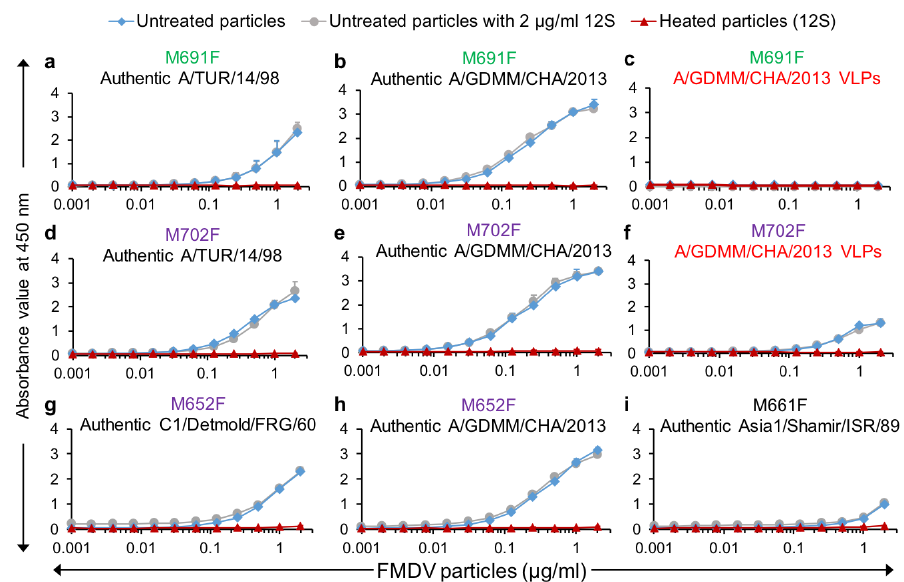
Figure 5. Capsid specificity of selected VHHs and interference of 12S particles in capsid quantification in DAS-ELISAs. Titrations of untreated authentic particles ( a , b , d , e , g – i ) or untreated VLPs ( c , f ) and their 12S particles from four FMDV strains in selected DAS-ELISAs as indicated on top of each panel (VLPs are marked in red). Another titration was done with a 2-fold dilution series of untreated FMDV particles to which a constant amount of 2 µg/mL 12S particles was added to measure interference of 12S particles. VHHs that bind specifically to 146S of serotype A strains are colored green or purple by their CDR3 group. Mean and standard deviation of triplicate ELISAs are given.